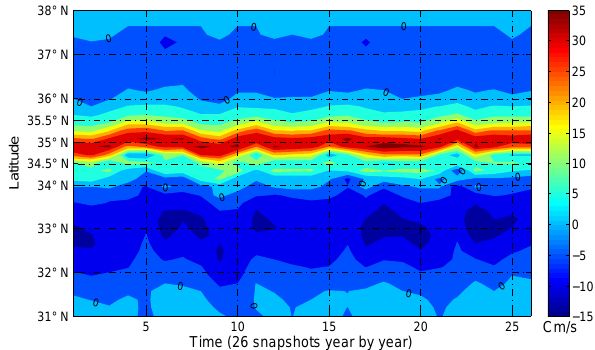
Fig. 6. Contour plot of the simulated zonal geostrophic velocity at 75 ◦ W as a function of